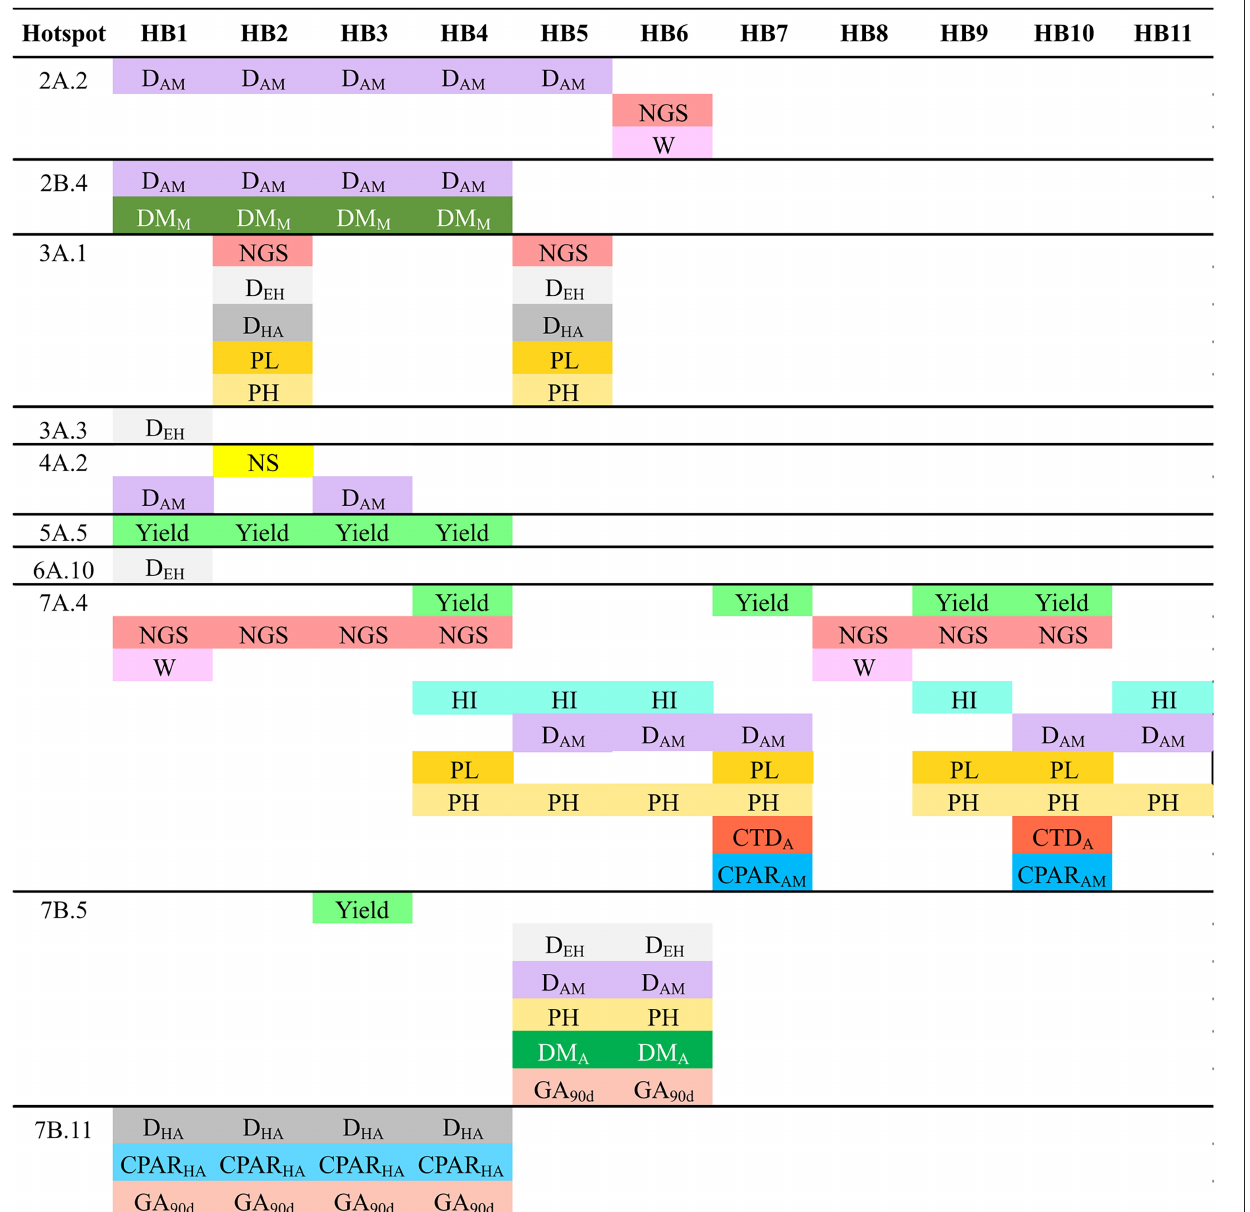
FIGURE 5 | Allelic differences among SPs in each one of the QTL hotspots as reported in Figure 4 and associated agronomic traits. NS, number of spikes/m 2 ; NGS, number of grains/spike; W, grain weight; HI, harvest index; DEH, days from emergence to heading; DHA, days from heading to anthesis; DAM, days from anthesis to maturity; PL, peduncle length; PH, plant height; DM A , dry matter at anthesis; DM M , dry matter at maturity; CTD A , canopy temperature depression at anthesis; cPAR HA , absorbed radiation from heading to anthesis; cPAR AM , absorbed radiation from anthesis to maturity; GA 90d , green area accumulated at 90 days from